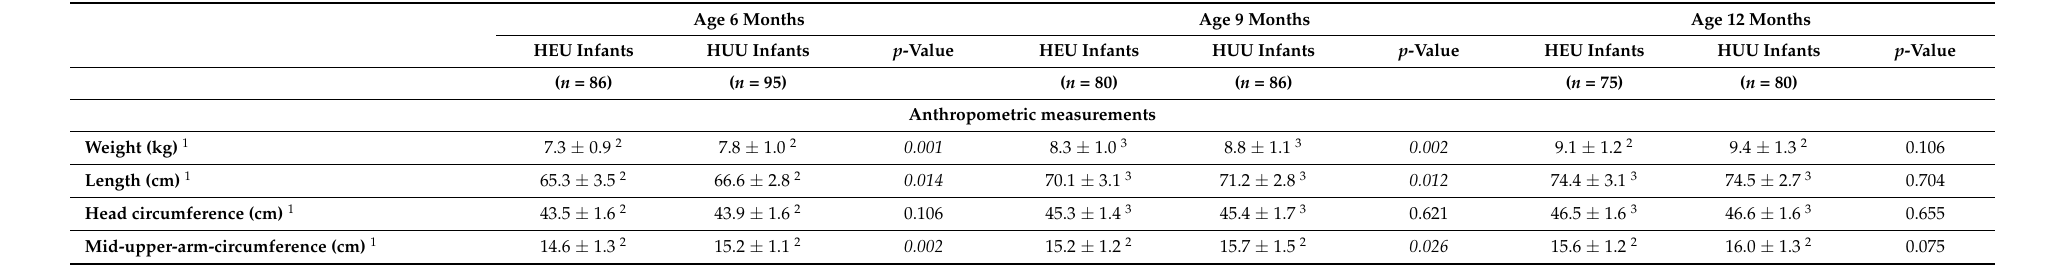
Table 5. Anthropometric measurements, Z-score indices, and nutritional classifications of the infants between 6–12 months of life by HIV exposure